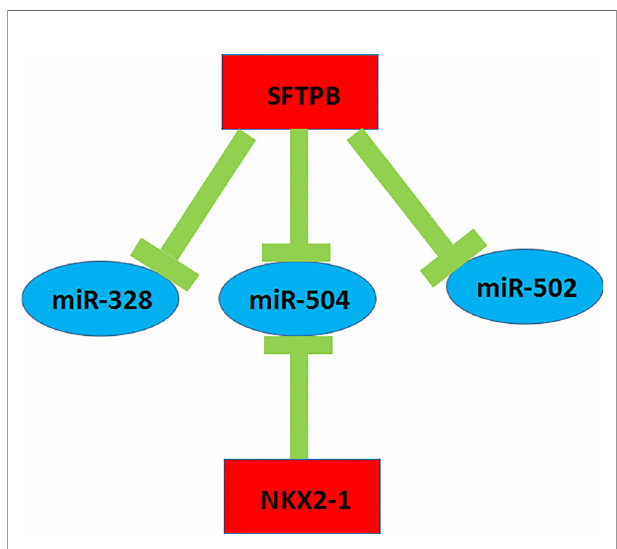
FIGURE 8 | The novel mRNA-miRNA regulatory network associated with prognosis of the patients with